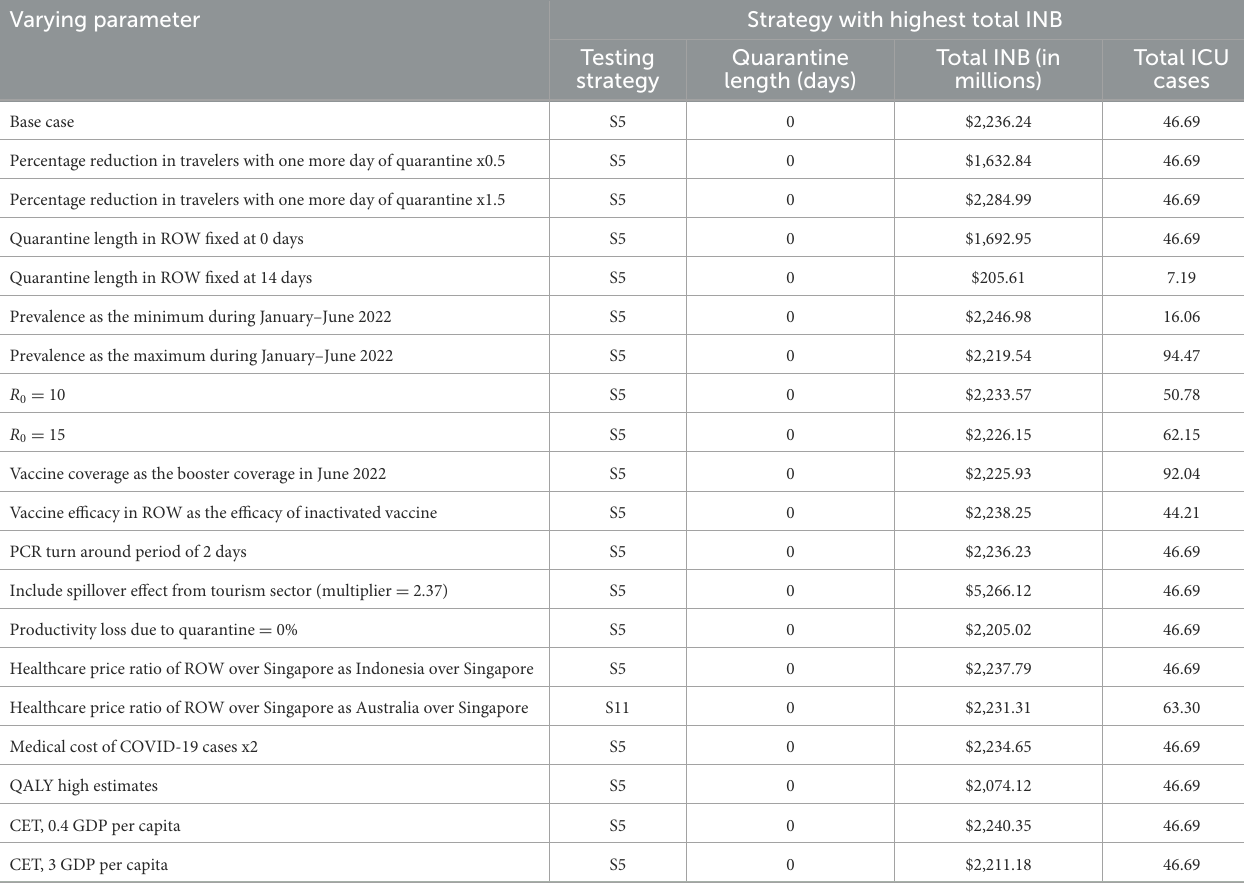
TABLE 5 Deterministic sensitivity analysis for economically optimal policy. Varying